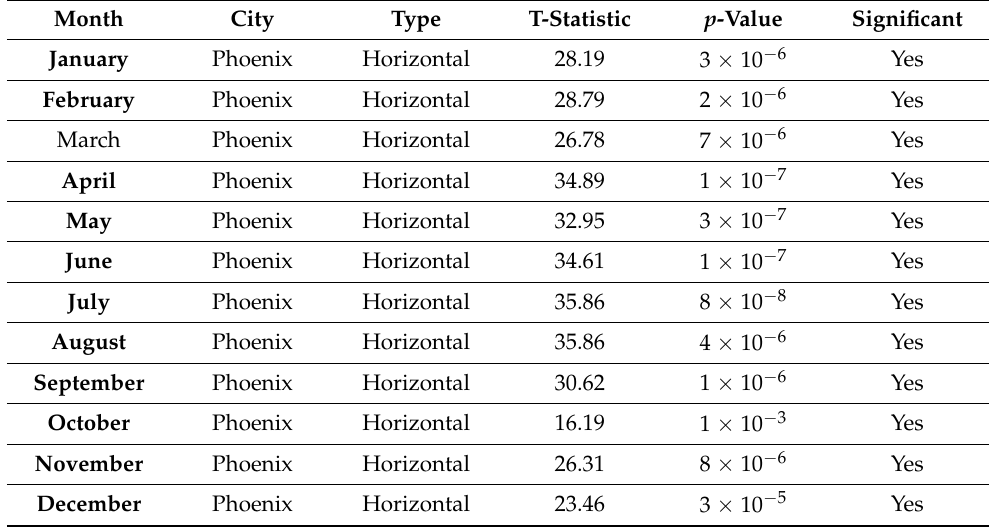
Table 15. Significant differences among different building orientations including south-facing, north- facing, east-facing, and west-facing in